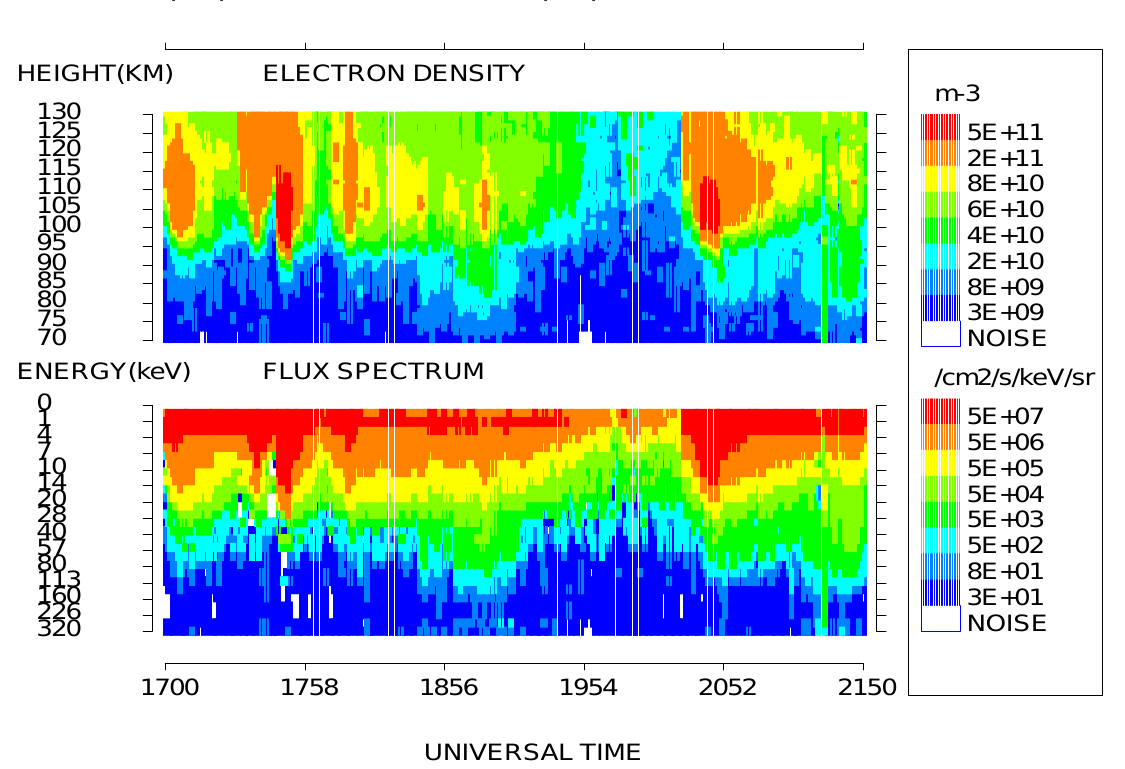
Fig. 2. (Top) Electron density profiles measured by EISCAT and (bottom) calculated energy-flux spectra (the differential flux) during 12 Feb 1999 at 17:00–22:00UT and 1min resolution. The colour scales are given on the right-hand side in m − 3 for the electron density and in /keV/cm 2 /s/sr for the